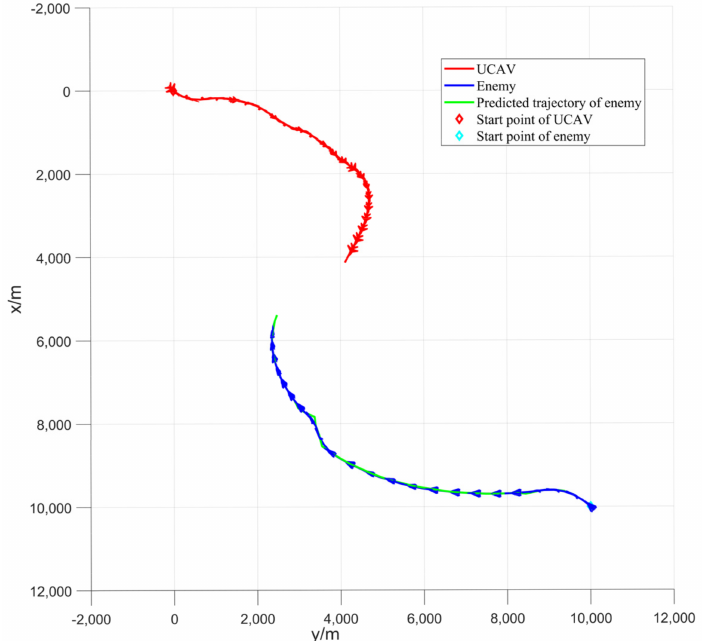
Figure 15. Top view of air combat trajectory and predicted trajectory.